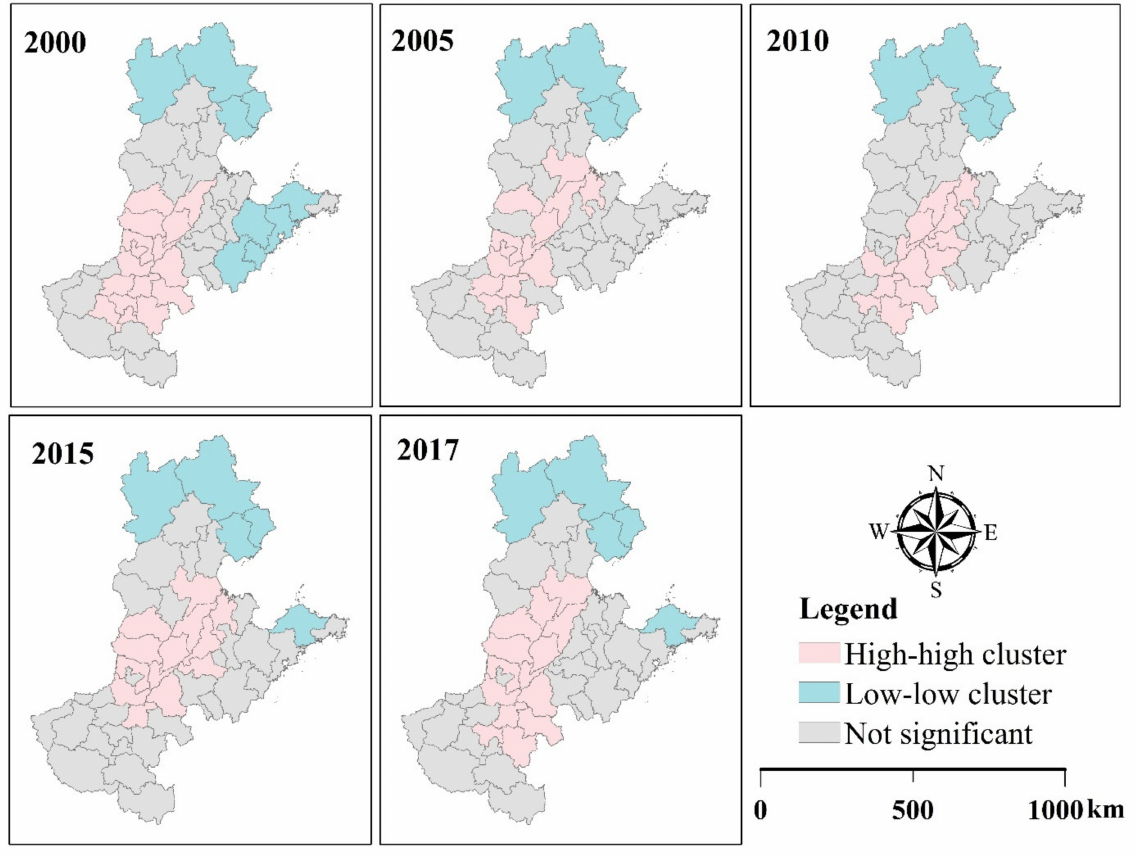
Figure 4. Local Moran’s I scatterplots for 2000, 2005, 2010, 2015, and 2017 (data source: http://fizz.phys.dal.ca/~atmos/ martin/) (accessed on 15 March